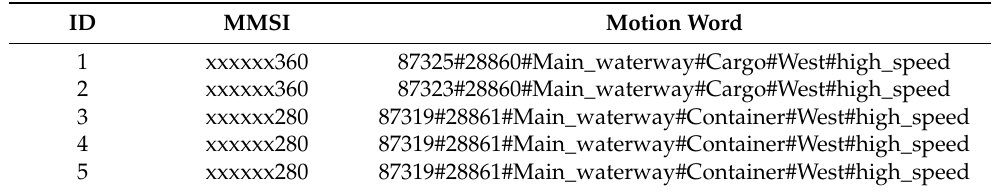
Table 5. Examples of textual representations of ship